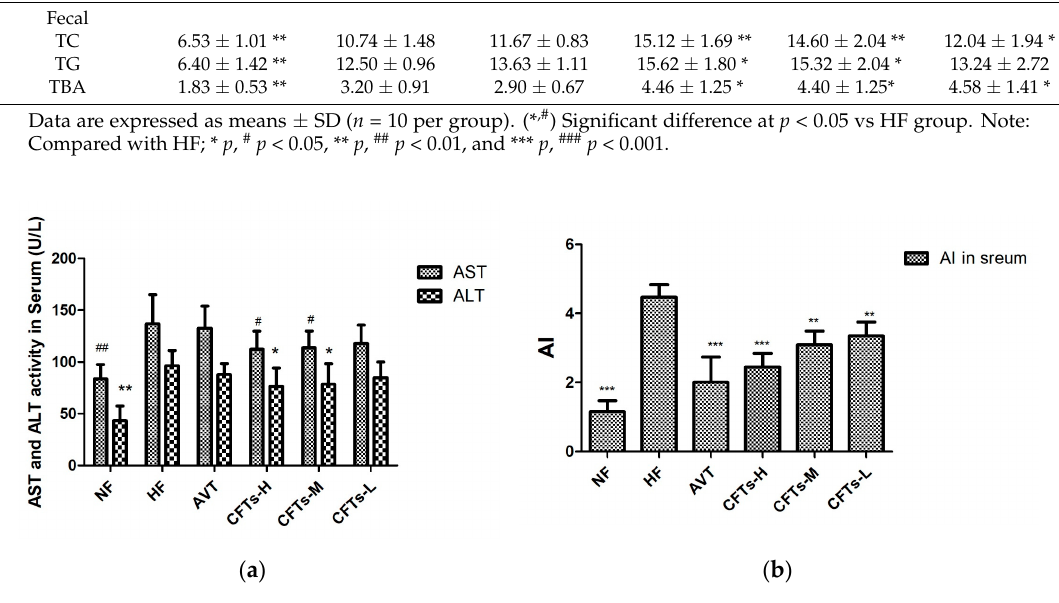
Figure 3. Serum aminotransferase and arteriosclerosis levels. ( a ) AST and ALT index in serum; ( b ) AI index in serum. The data are presented as the means ± SD ( n = 10). (* ,# ) Significant difference at p < 0.05, (** ,## ) significance difference at p < 0.01 and ( ### ) significance difference at p < 0.001 VS the HF group.